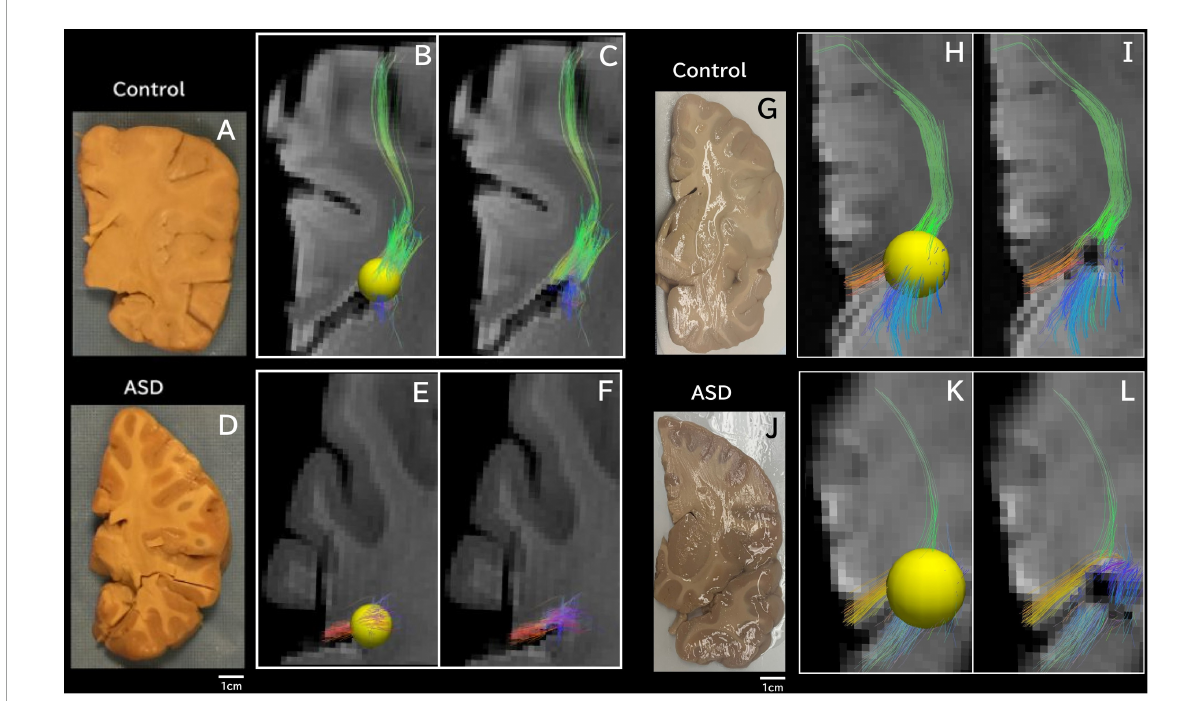
FIGURE3 Tractography pathways associated with the dorsal SVZ are more sparse and fewer in ASD compared to control ex vivo . Tractography pathways associated with the dorsal SVZ in (A–C) control 6032; 4 years and 51 days old; (D–F) ASD #M4021M; 3 years 114 days old; (G–I) Control #5282; 2 years 308 days old; and (J–L) ASD #5308; 4 years 183 days old. Yellow spheres (4 mm radius) in each brain image were created in the dorsal SVZ as regions of interest (ROIs) to detect pathways from/to the ROIs. Tractography pathways without the ROIs are shown in (C,F,I,L) . Brain images (A,D) were previously published (Wilkinson et al.,